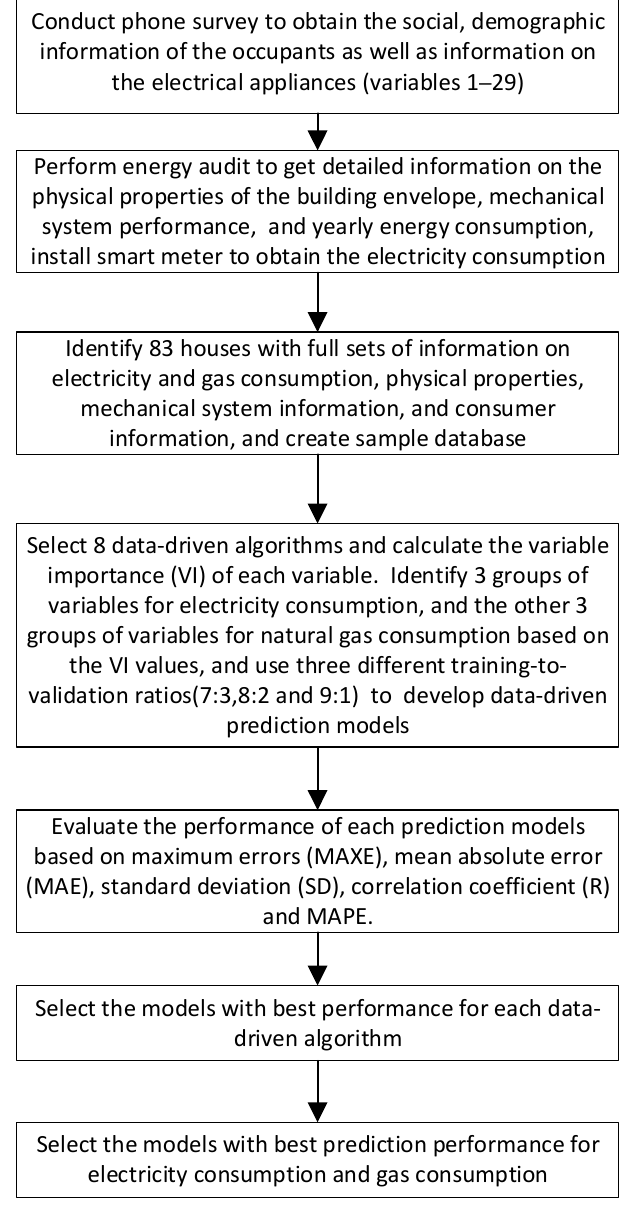
Figure 1. Flowchart of the research strategy.